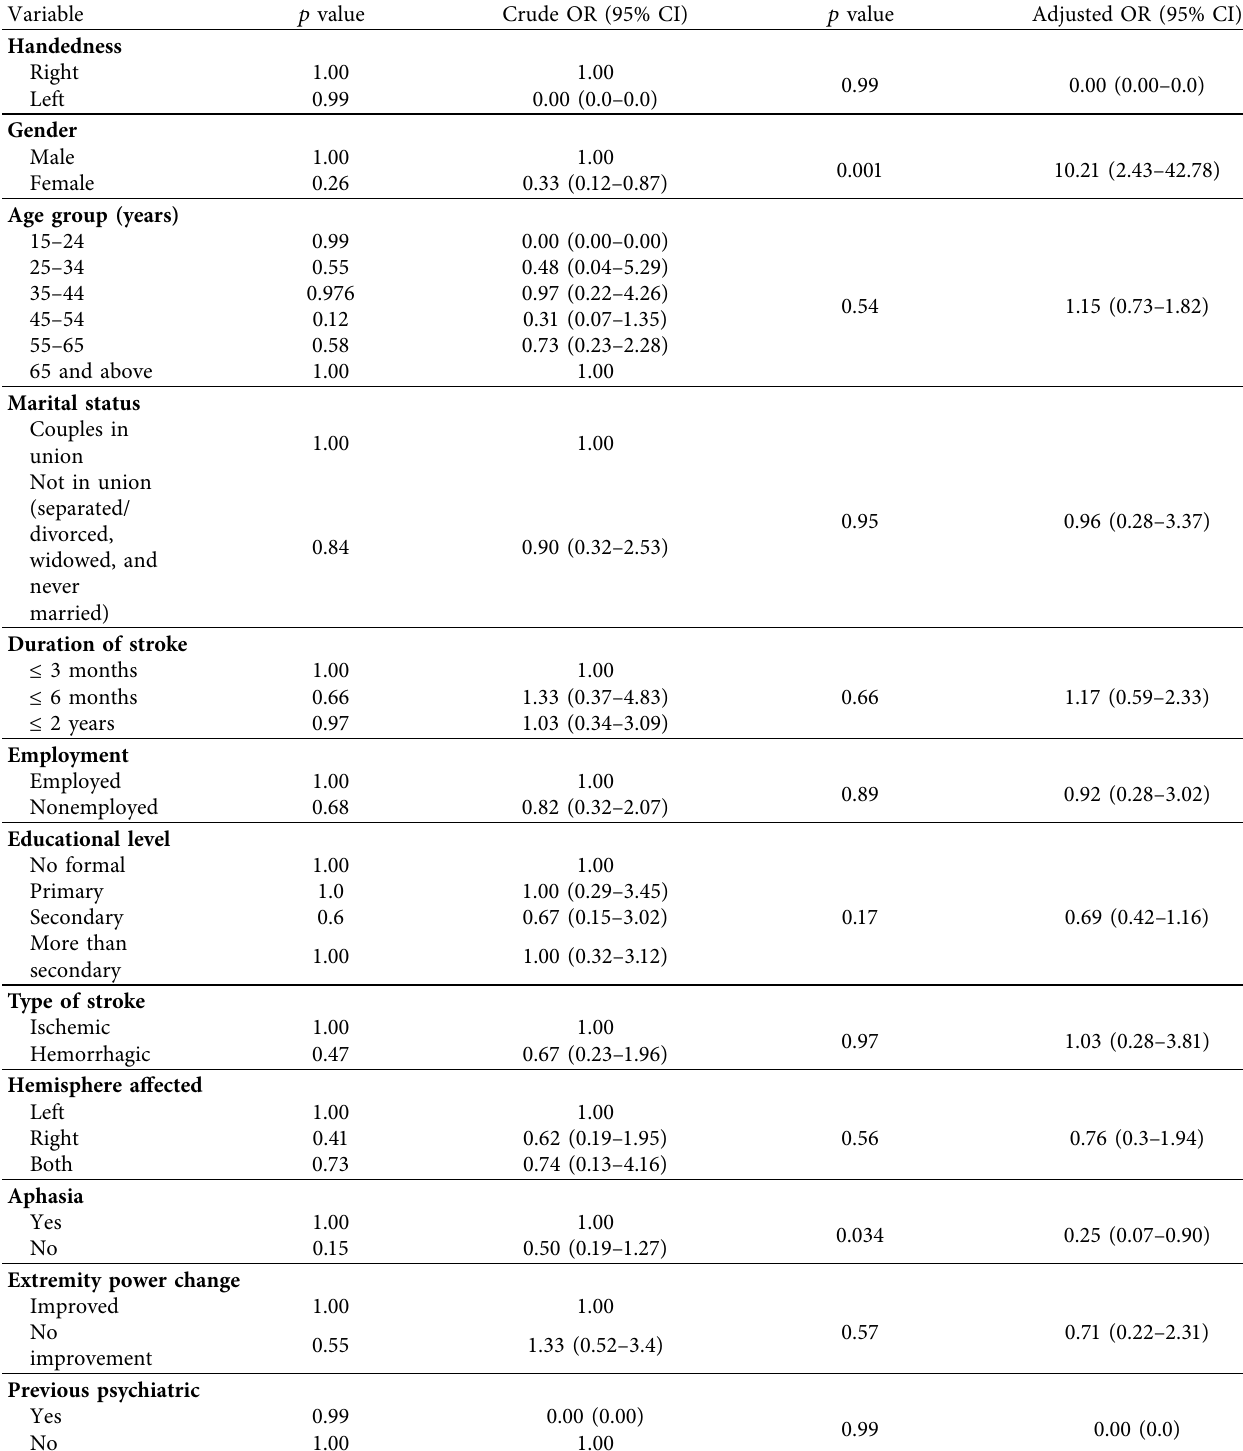
Table 4: Factors associated with screening positive for poststroke depression imaging among stroke patients at TASH and ZMH neurology